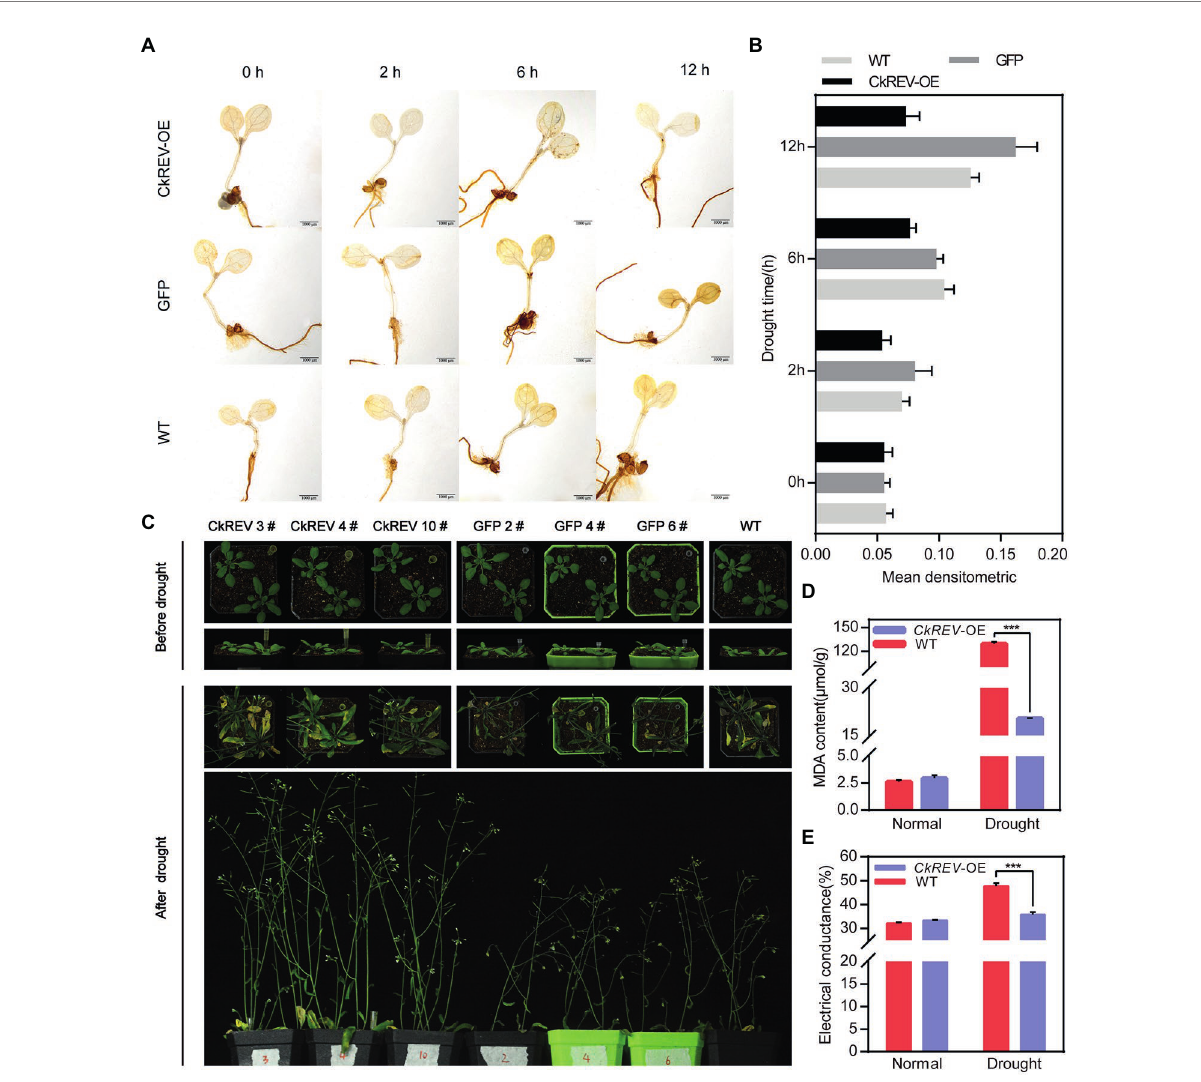
FIGURE 6 CkREV significantly enhances drought tolerance in plants by facilitating xylem development in leaf veins. (A) Arabidopsis thaliana CkREV -OE lines, GFP-OE lines, and the wild-type seedlings are placed on PEG medium for simulated drought treatment for corresponding durations prior to DAB staining on ROS within them and darker brown indicates higher ROS content. Scale bar = 1 mm. (B) Statistical analysis of mean densitometric analysis of ROS staining in A. thaliana after drought treatment. (C) Observation on living status of A. thaliana CkREV -OE lines, GFP -OE and the wild type after natural drought treatment. (D,E) Physiological indices determination on transgenic A. thaliana , malondialdehyde content (D) , and relative conductivity measurement (E) . Error bars indicate SD ( n = 3). (D,E) Student’s t -test is employed to measure statistical significance between two samples with confidence level at 0.95 (*** p <